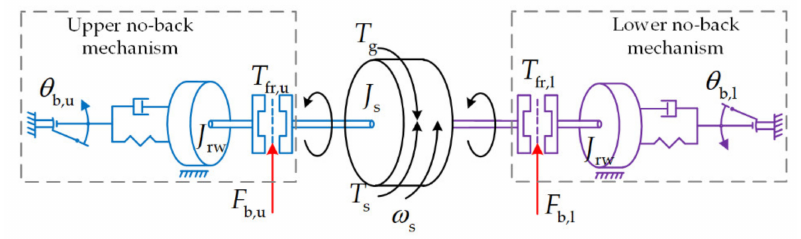
Figure 5. Schematic diagram of no-back